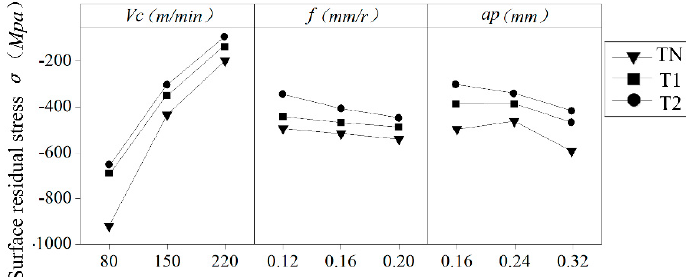
Figure 17. Single factor e ff ect of cutting parameters on the surface residual